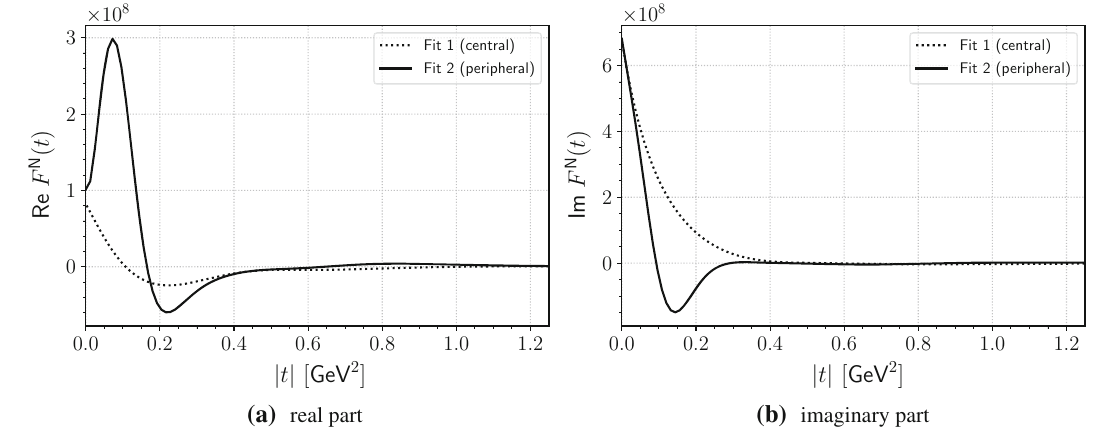
Fig. 10 The real and imaginary parts of elastic hadron scattering amplitude corresponding to Fits 1 and 2 at 8 TeV